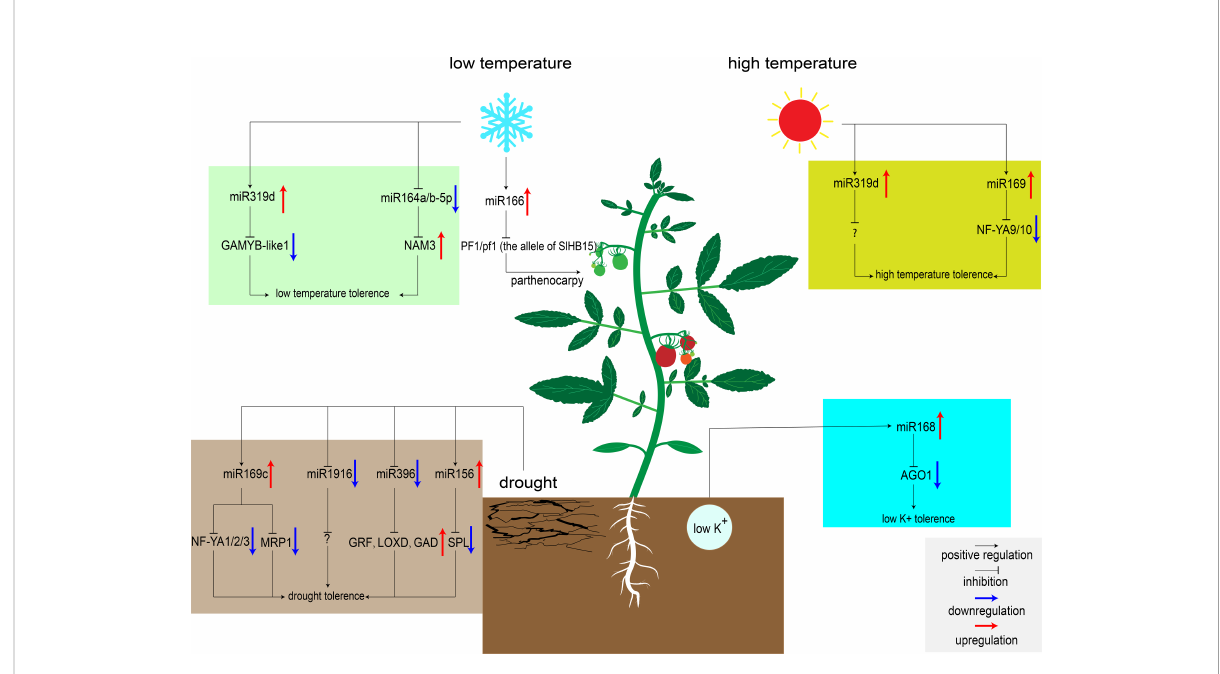
FIGURE 1 MiRNAs regulate tomato response to abiotic stresses. MiR319d was induced by low temperature to inhibit the expression of target genes GAMYB-like1 and improving tomato cold tolerance (Shi et al., 2019). MiR166 was also induced to express by low temperature. When embryonic development is blocked, low temperature induces parthenocarpy in heterozygous genotype plants (Clepet et al., 2021). Low temperature will down-regulate the expression of miR164a/b-5p, release the inhibition of NAM3, and improve the cold tolerance of tomato (Dong et al., 2022). High temperature upregulates the expression of miR319d and miR169, and inhibiting the transcription of downstream target genes to improve tomato heat tolerance (Shi et al., 2019; Rao et al., 2022). However, the target genes of miR319d at high temperature are unknown. miR169c and miR156 were up-regulated under drought, inhibited the expression of downstream transcription factors, and improved tomato tolerance to drought (Zhang et al., 2011; Visentin et al., 2020). While miR1916 and miR396 were down-regulated under drought condition, regulating downstream signaling pathways to improve tomato tolerance to drought (Chen et al., 2019; Fracasso et al., 2021). The target genes of miR1916 under drought stress are currently unknown. Low potassium stress induces the expression of miR168, inhibits the expression of AGO1, and enhances K + uptake by regulating downstream signaling pathways (Liu et al.,